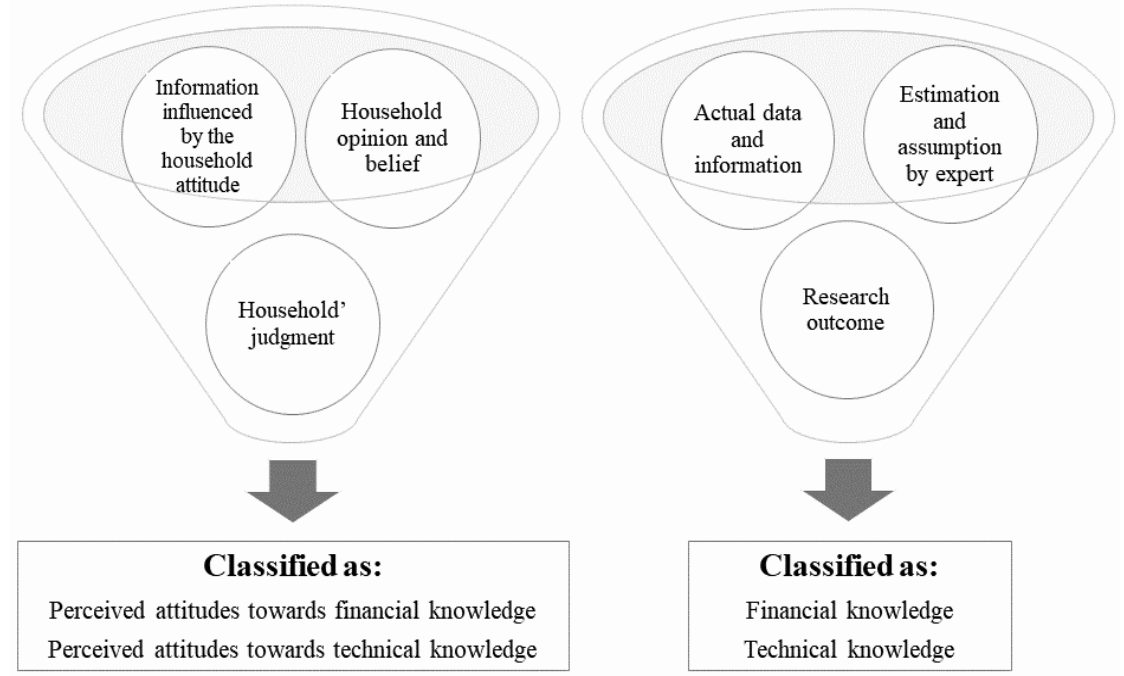
Figure 2. Distinction between the financial and technical predictors in both categories based on their input data.